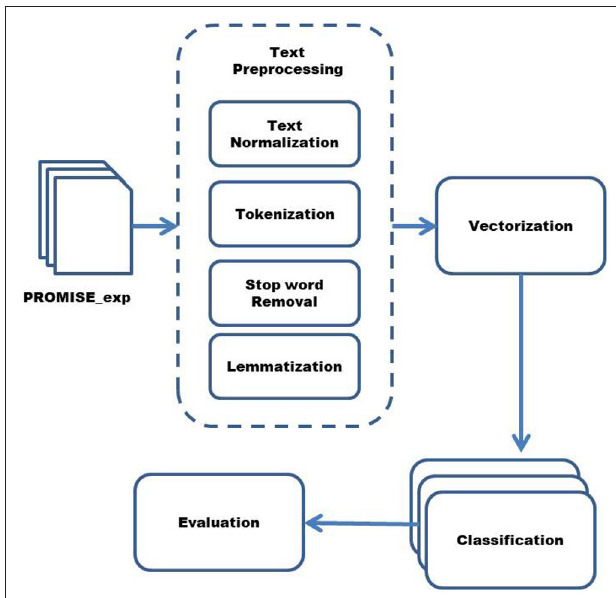
FIGURE 1 | Steps of classifying non-functional requirements.